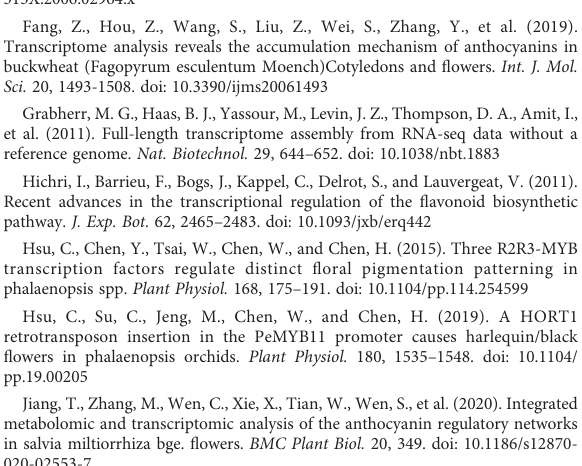
SUPPLEMENTARY FIGURE 4 Correlationanalysesbetweenanthocyaninbiosynthesisrelatedgenesand anthocyanin content in different fl oral tissues of two Dendrobium hybrid families. Correlation matrix analyses between anthocyanin biosynthesis related genes and total anthocyanin content (TAC) in different fl oral tissues (sepals, petals and lips) in hybrid progenies from “ ED ” or “ BP ” , respectively. Twenty F1 progenies of each hybrid family were